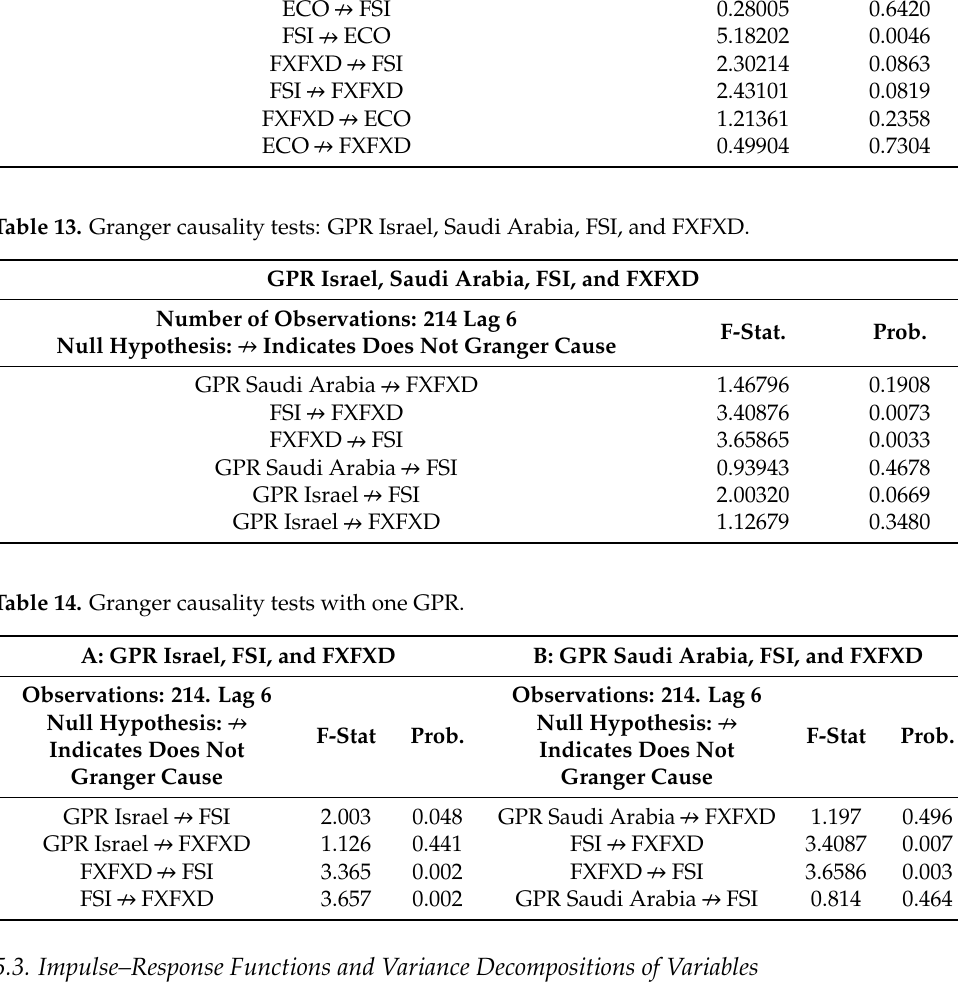
Table 11. VAR residual serial correlation with one GPR. Table 12. Granger causality Tests: ECO, FSI, and FXFXD.